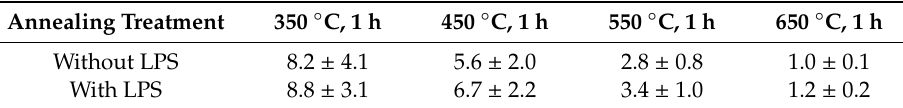
Table 4. Values of the ratio of average grain size to thickness (the N value) of the copper foils under different conditions.